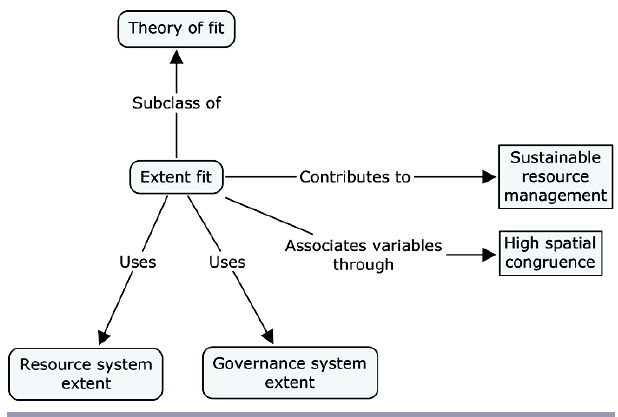
Fig. 4 . Extent fit.